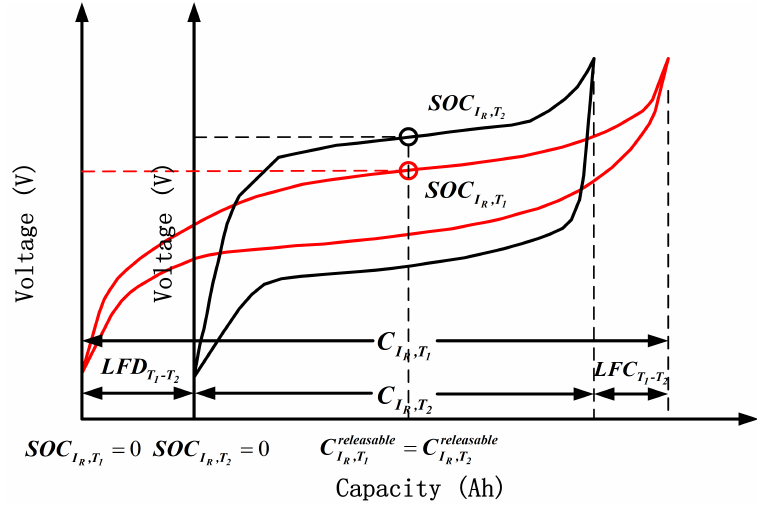
Figure 10. The conversion of SOC between different